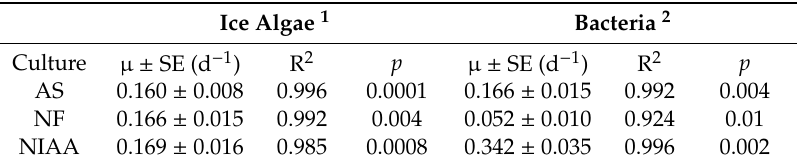
Table 2. Apparent specific growth rates ( µ ) of ice algae and heterotrophic bacteria derived from a non-linear fitting of data obtained from the exponential growth phases of ice algae and bacteria (see Figure 1A,B). Ice Algae 1 Bacteria